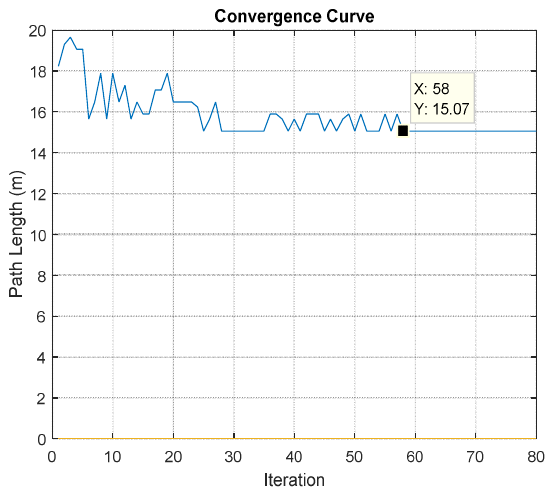
Fig. 19. The Convergence Curve for Experiment 1 From the previous two figure, the mobile robot start avoids static obstacles with the shortest path